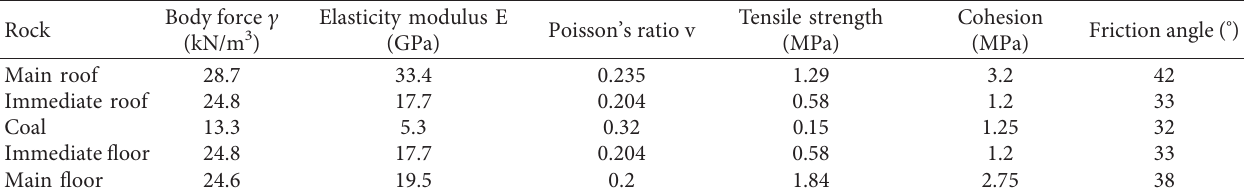
Table 3: Physical and mechanical parameters of coal and rock mass.